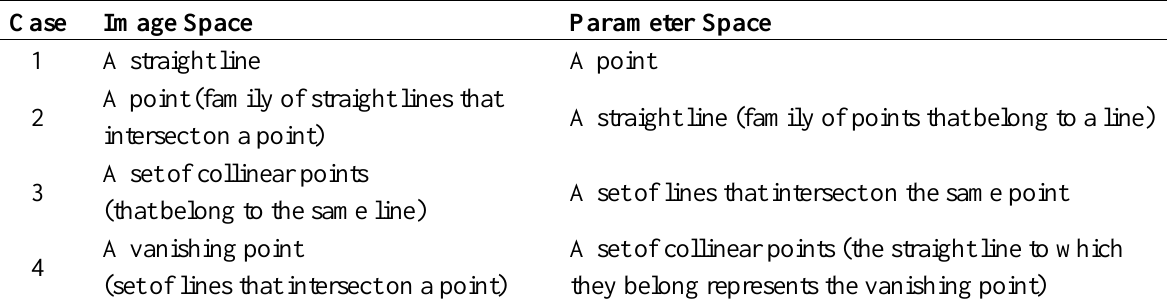
Table 1. Different cases between image and parameter spaces for the Hough